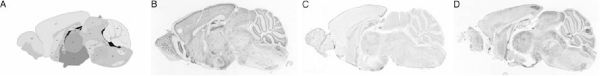
In situ hybridization images. A. Reference image at position 4000. Expression images for B. Abr, C. Adcy5, D. Astn1. B is one of the best quality images. Most of the images are of quality C. D is among the worst quality.